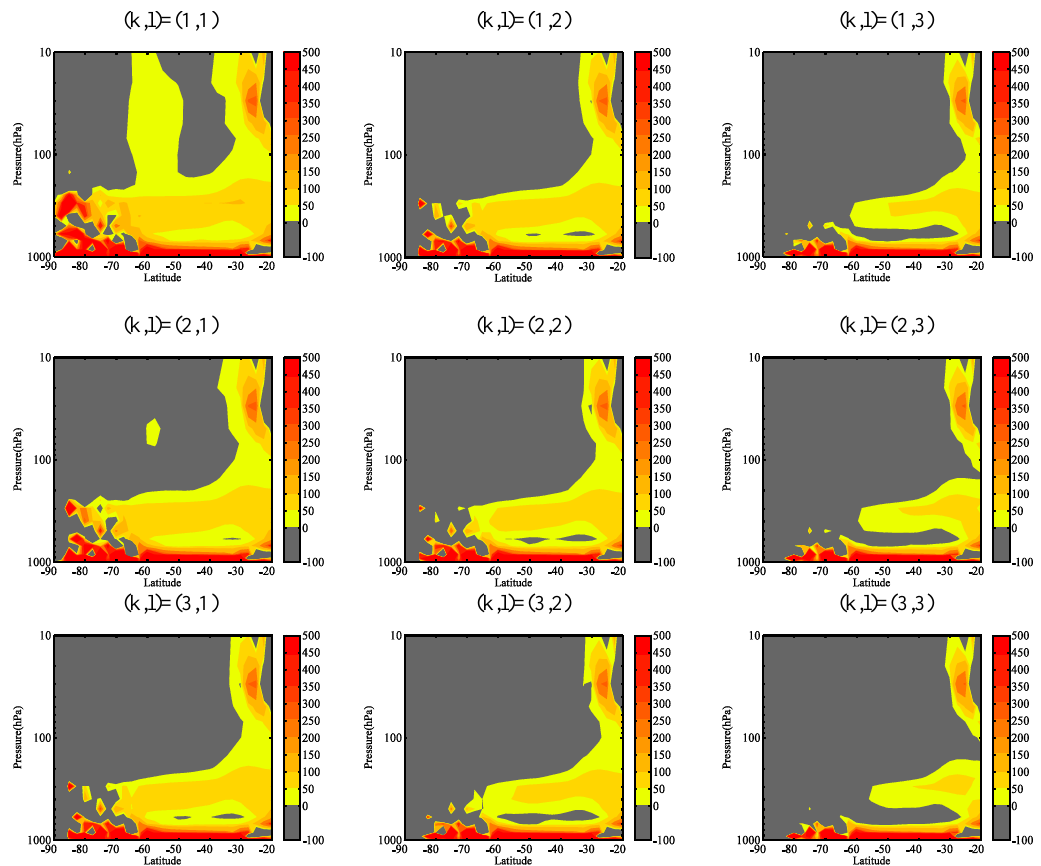
(y,z) ) of 50 winters (1961–2010) in the Southern Hemisphere. Regions with k,l